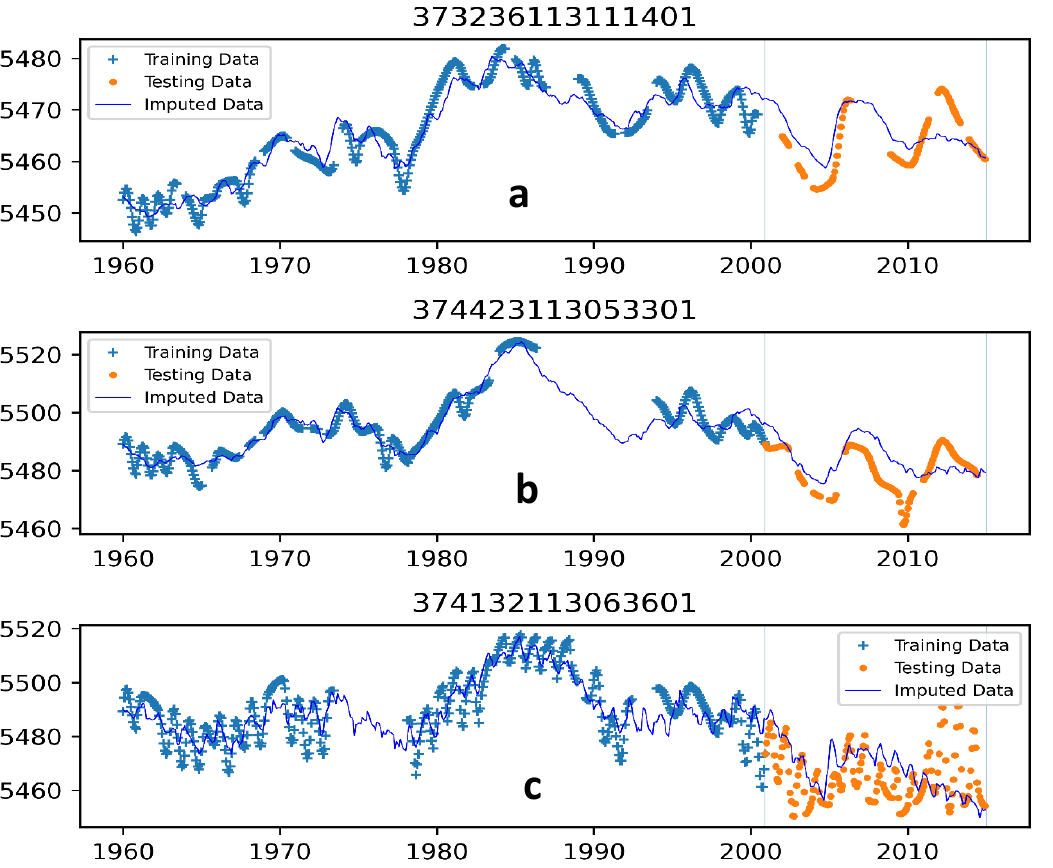
Figure 6. ELM results over a 15 year testing period from 2000–2015 for Wells 37236113111401, 374423113053301, and 374132113063601 as subfigures ( a – c ), respectively. Imputed data are solid blue lines, measured data used for training are blue crosses, and measured data used for testing are orange dots.